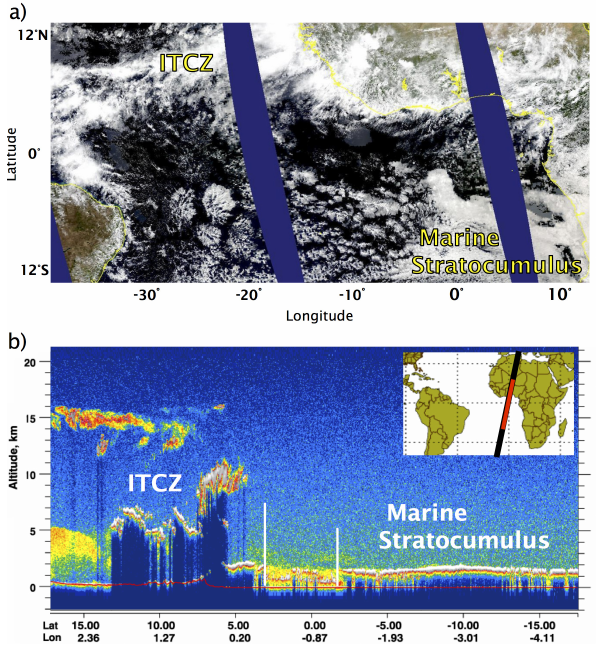
Figure 3. (a) Aqua MODIS true color image (RGB) of the tropi- cal and Southern Hemisphere subtropical Atlantic Ocean on 8 July 2012. (b) CALIPSO CALIOP 532nm total attenuation backscatter presenting a vertical profile of cloud and aerosol while crossing the eastern Atlantic Ocean on the same day. Note the area of relatively lower cloud amount between the tropical deep convective clouds and subtropical marine stratocumulus